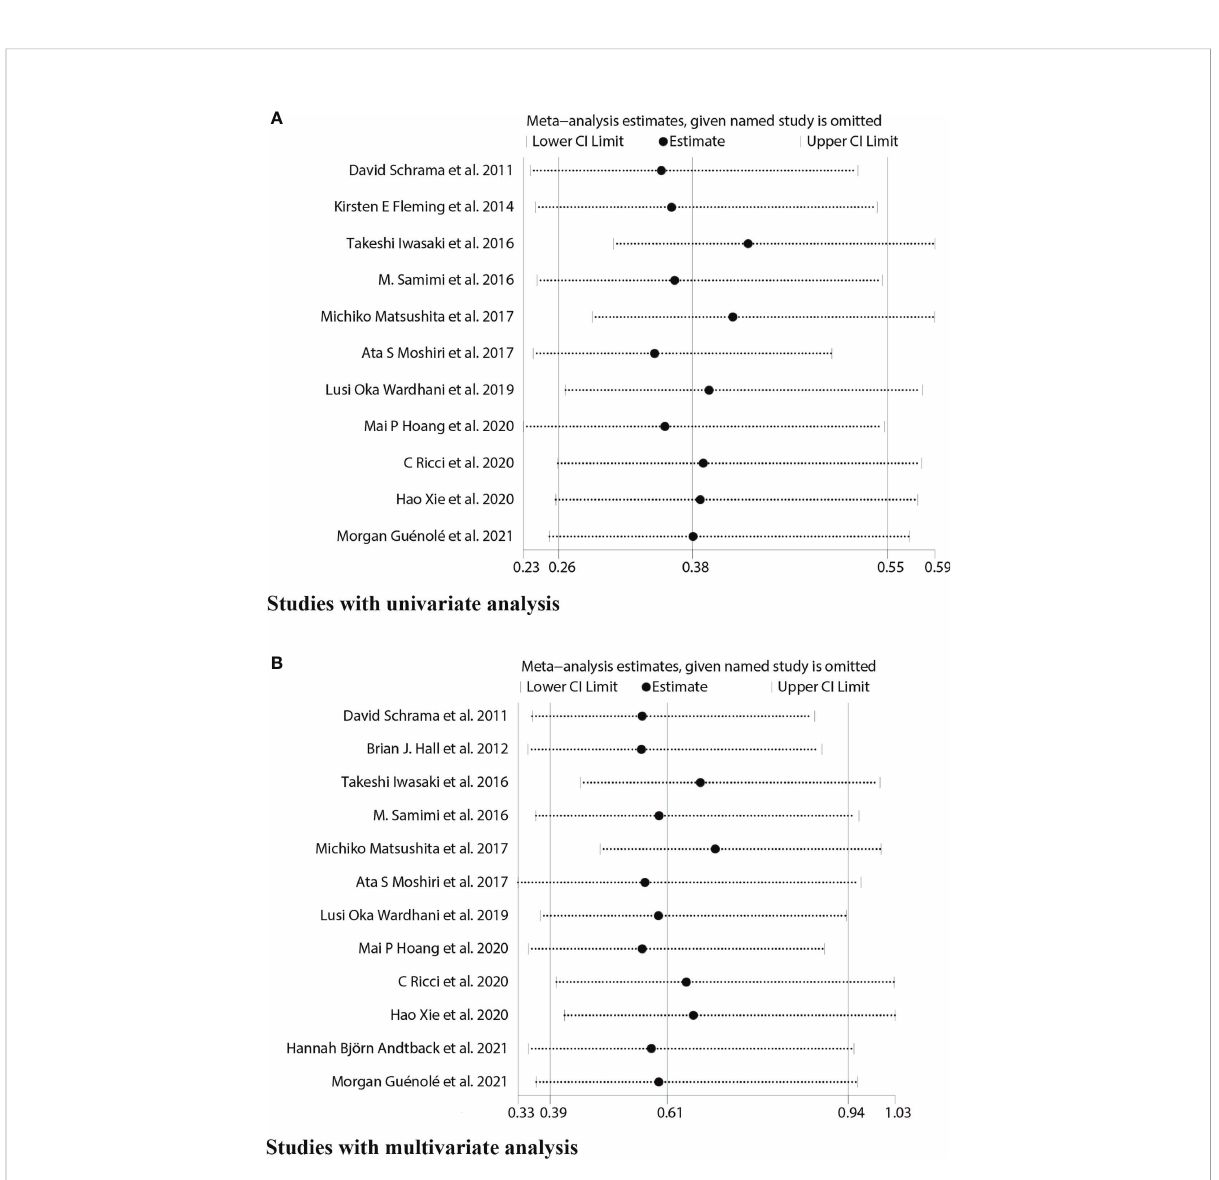
FIGURE 7 Sensitivity analyses for studies on the association between MCPyV positivity and overall survival(OS). (A) univariate analysis. (B) multivariate analysis.